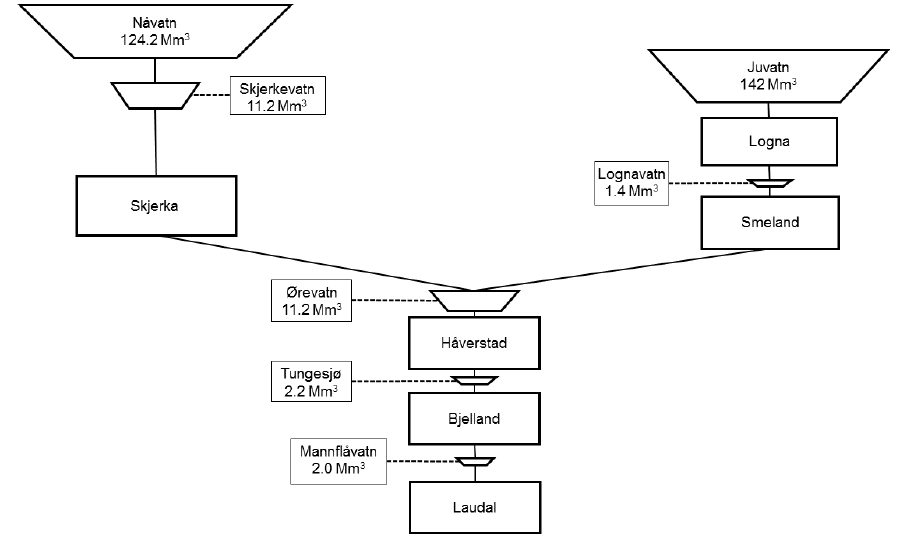
Figure 2. A sketch of the water course topology used in the case study. There is large storage capacity in the upstream reservoirs, while the downstream parts are similar to run-of-river systems due to small reservoir sizes. The challenge is to schedule releases from the upstream reservoirs in order to keep the pressure height in the smaller downstream reservoirs high while at the same time having enough free capacity in the reservoirs to absorb the inflows coming in. River-flow time delay between reservoirs further complicates this